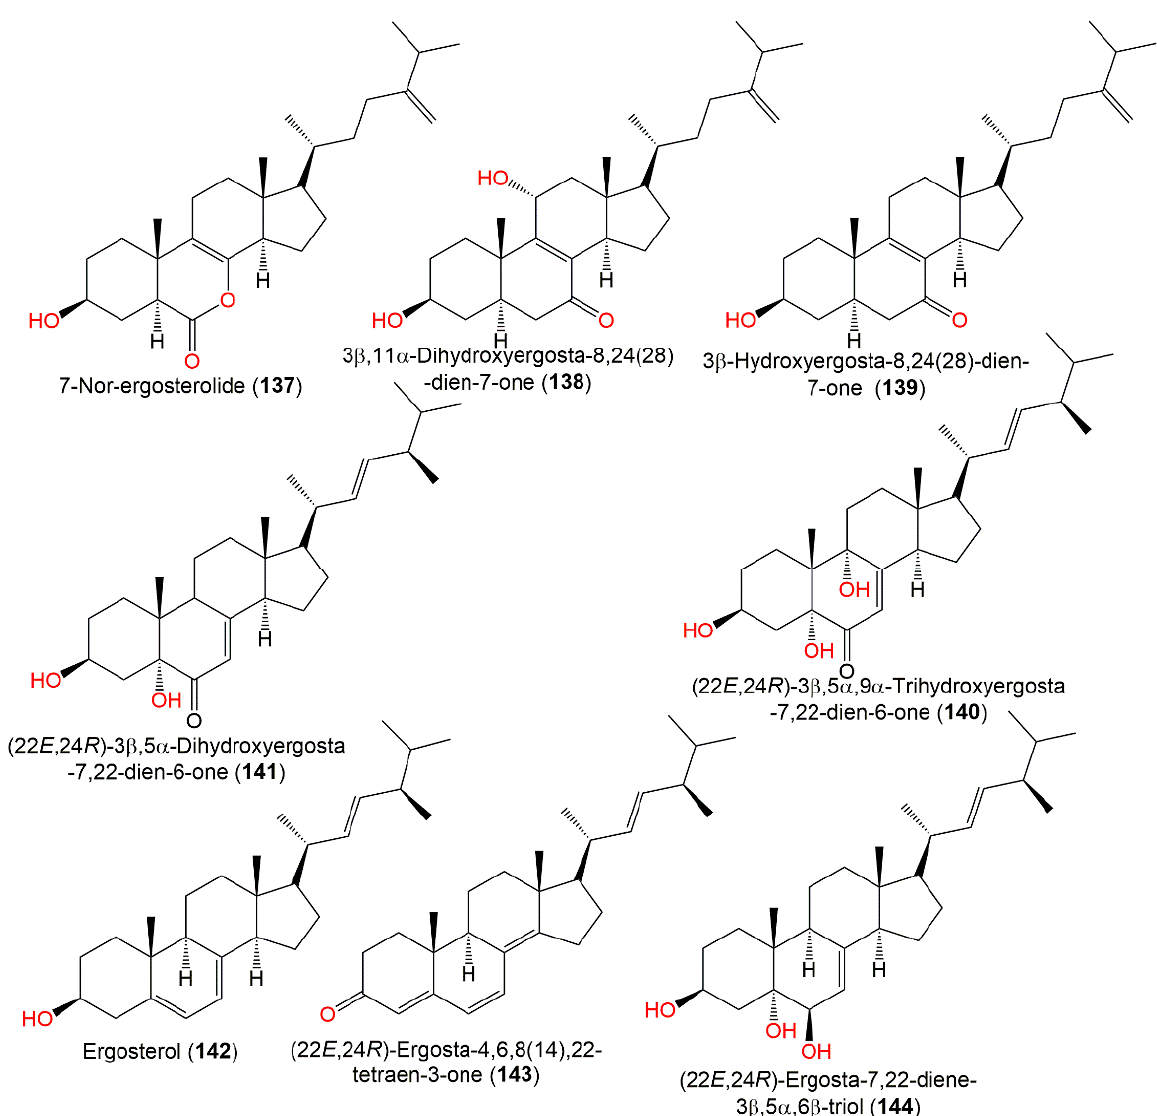
Figure 13. Sterols ( 137 – 145 ) reported from A. ochraceus. Compound 137 is a rare 7-norsteroid with an uncommon pentalactone B ring sys- tem [27]. It demonstrated selective cytotoxic potential towards SW1990, NCI-H460, and SMMC-7721 cell lines (IC 50 28.0, 5.0, and 7.0 µ g/mL, respectively), while 138 revealed selectivity (IC 50 28.0 µ g/mL) towards SMMC-7721 in the MTT assay and both had no an- timicrobial potential in the agar diffusion test [27]. 22 E ,24 R -Ergosta-7,22-diene-3 β ,5 α ,6 β ,9 α - tetraol ( 149 ), reported from A. ochraceus derived from fresh sea water, displayed no notable anti-H1N1 virus, anti-food allergic, and antimicrobial activities [80]. On the other hand, 143 – 154 isolated by Hu et al. from A. ochraceus MCCC3A00521EtOAc extract demonstrated anti-Parkinson’s disease efficacy (EC 50 ranged from 35.71 to 49.53 µ M) (Figure 14)